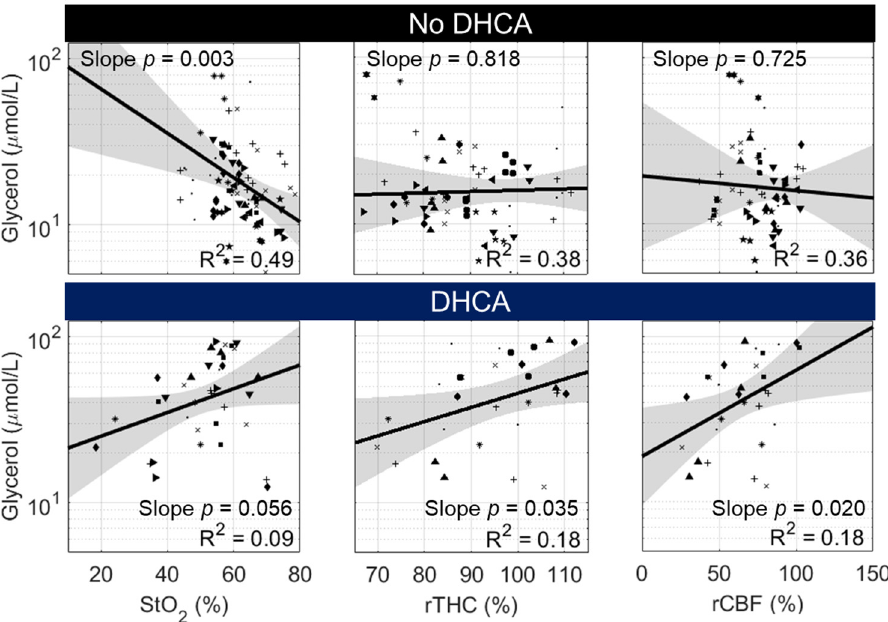
Figure 4. Correlation between Cerebral Glycerol and Cerebral Hemodynamics in “No DHCA” and DHCA Groups. Correlation data from individual animals are designated by a unique symbol within “No DHCA” animals (i.e., animals randomized to DHCPB and SACP groups) and, separately, within DHCA animals. In “No DHCA” animals, a significant negative slope effect was detected in the linear mixed-effects model examining the relationship between log-normalized glycerol concentration and StO 2 , but not with rTHC or rCBF. Examining identical models in DHCA animals, trending ( p < 0.01) or significantly ( p < 0.05) positive slope effects were observed between log-normalized glycerol and all three parameters.